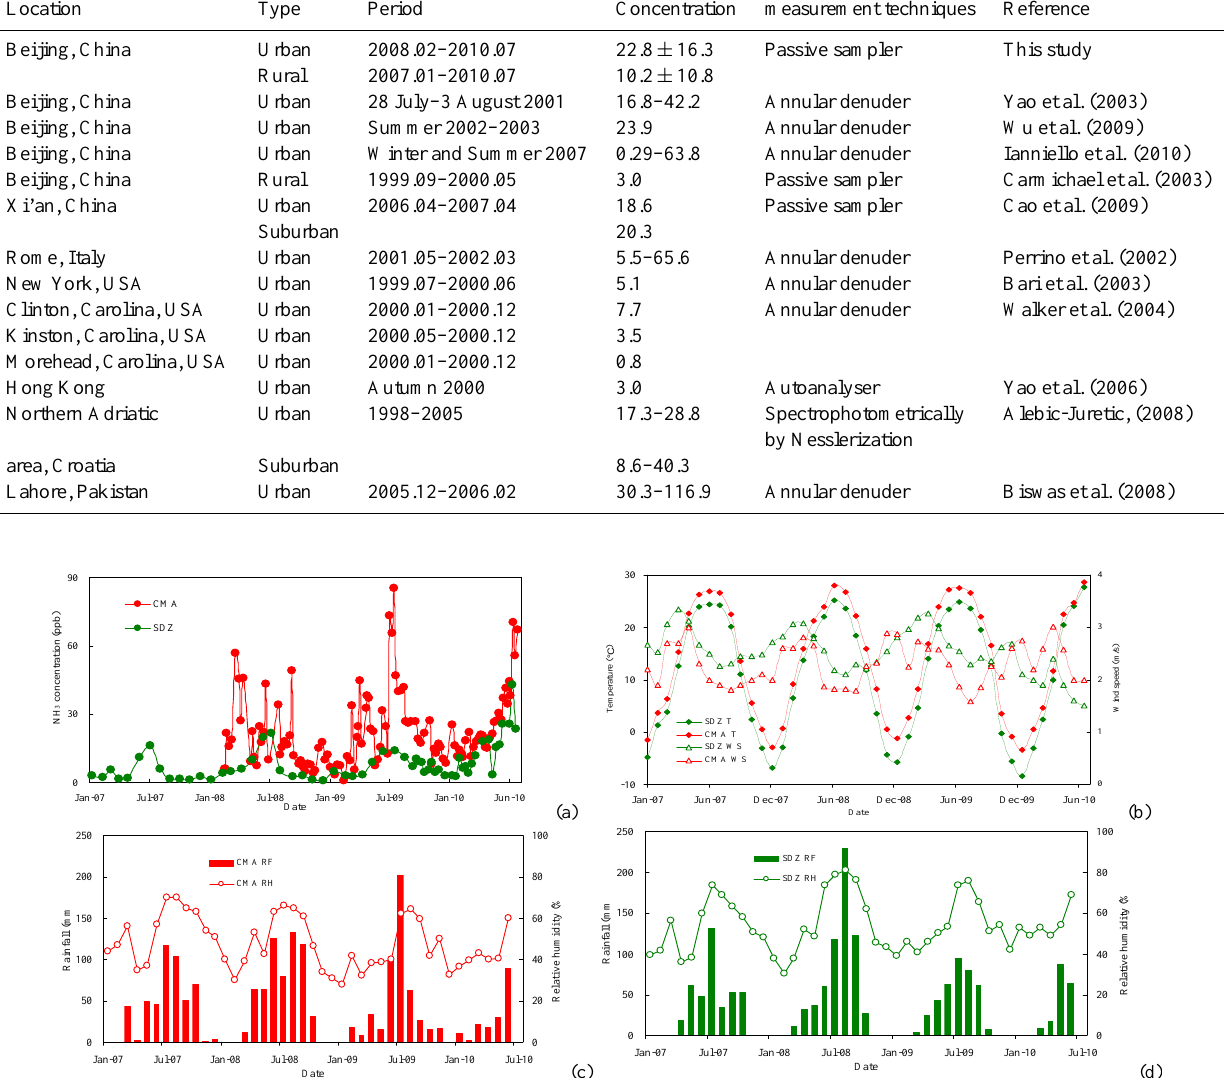
Table 2. Comparison of NH 3 concentrations in Beijing with other areas, in ppb.